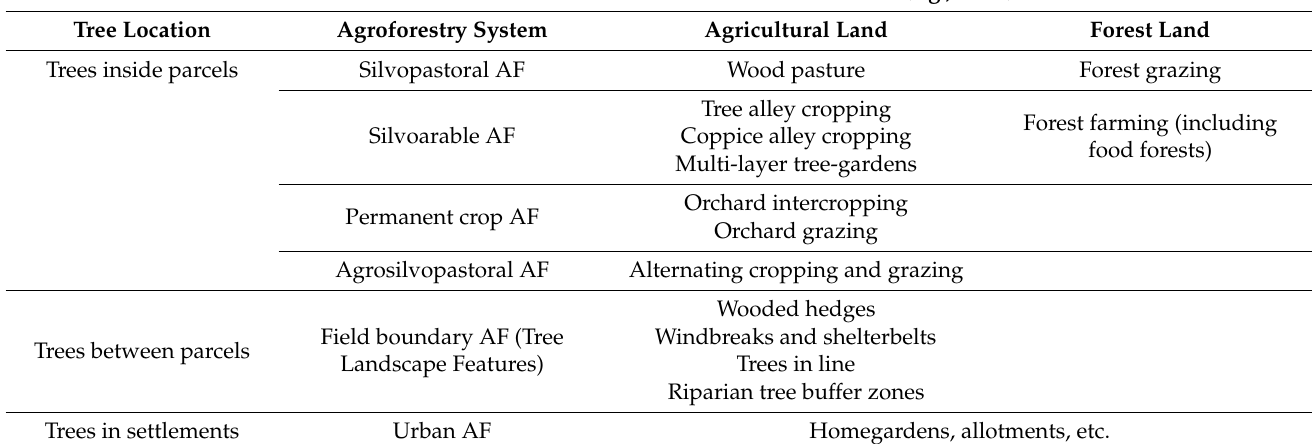
Table 1. Agroforestry systems and practices proposed by EURAF (modification of Dupraz et al. [26] for use in the post 2023 CAP, particularly in the Integrated Administration and Control System and the Land Parcel Identification System (LPIS). Agroforestry Practice—According to EU Land Use